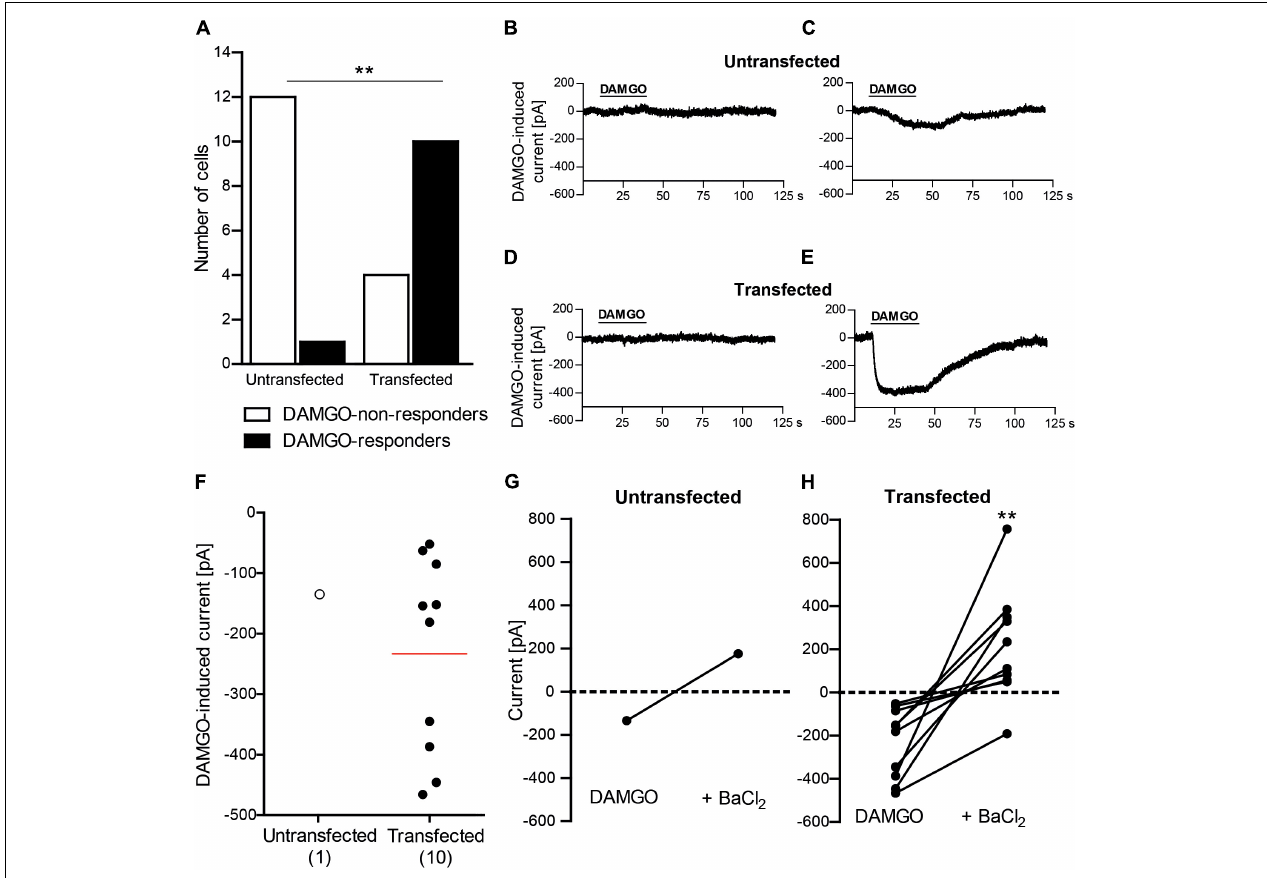
FIGURE 1 | DAMGO (10 µ M) induces potassium currents in HEK 293 cells transfected with rat MOR and mouse Kir3.2. (A) Number of DAMGO-responders and non-responders in untransfected and transfected cells. ∗∗ P = 0.0013 (Fisher’s exact test) indicates higher proportion of DAMGO-responders to DAMGO-non-responders in transfected vs. untransfected cells. The cells were sampled from three untransfected and four transfected cell cultures. (B–E) Exemplary traces of DAMGO-non-responder (B) and DAMGO-responder (C) in untransfected cells, and of DAMGO-non-responder (D) and DAMGO-responder (E) in transfected cells. (F) Single cell currents in DAMGO-responders. The data points represent single cell values, and the red horizontal line indicates the mean. Numbers in brackets indicate the number of cells. (G,H) BaCl 2 (3 mM)-mediated reversibility of DAMGO-induced currents in untransfected cells ( n = 1) (G) and transfected cells ( n = 10; ∗∗ P = 0.002, paired t -test) (H) . Only DAMGO-responders are shown. Data points represent DAMGO-induced currents of the same cell before and after application of BaCl 2 . Dotted lines represent zero current. In all experiments, the currents were recorded in voltage clamp mode at –80 mV in high potassium extracellular buffer (140 mM). Cells were defined as responding to DAMGO if the resulting current was larger than three times the noise